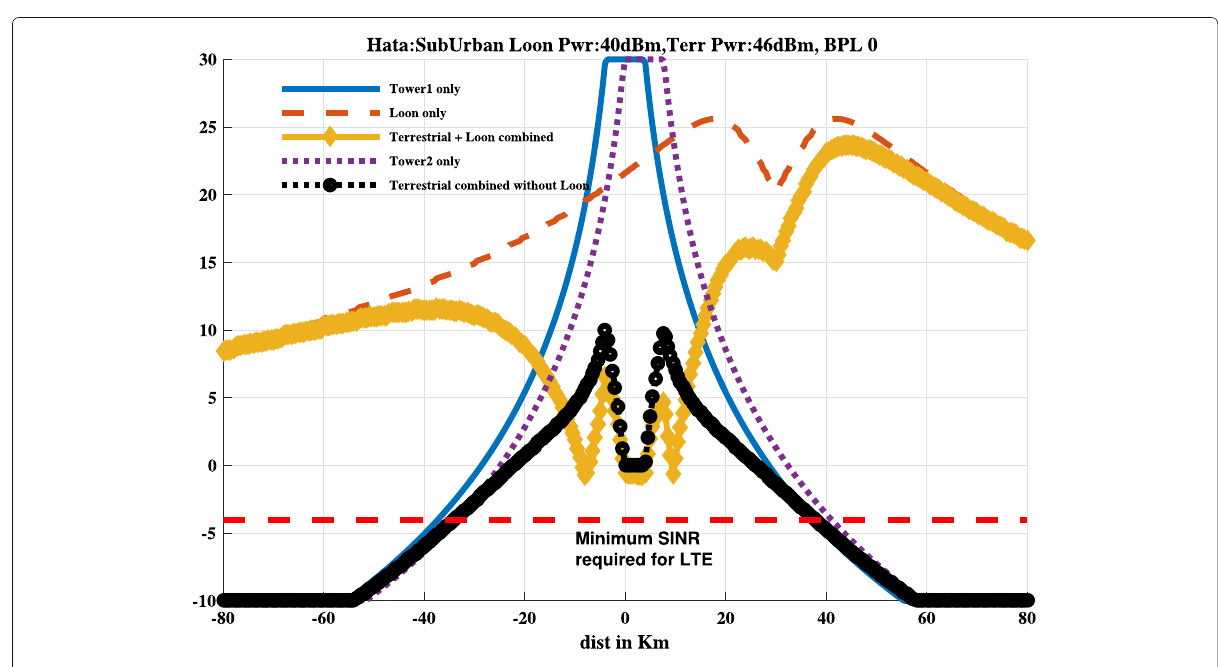
Fig. 7 Expected outdoor SINR with two suburban terrestrial towers and a Loon HAP